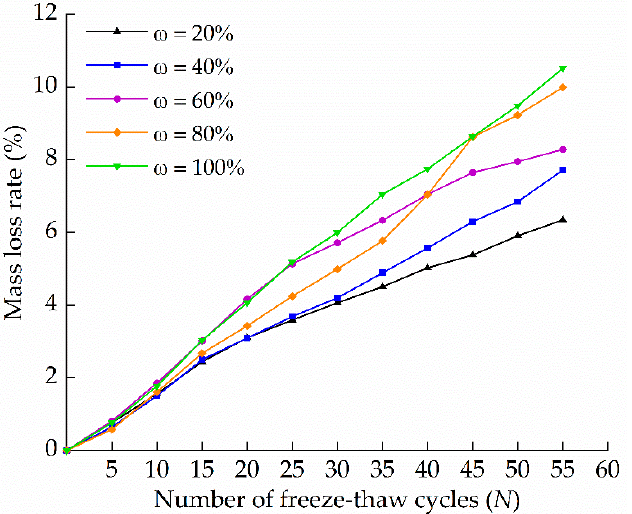
Figure 4. Relationship between mass loss rate and the number of freeze–thaw cycles of gray brick samples with different moisture contents.